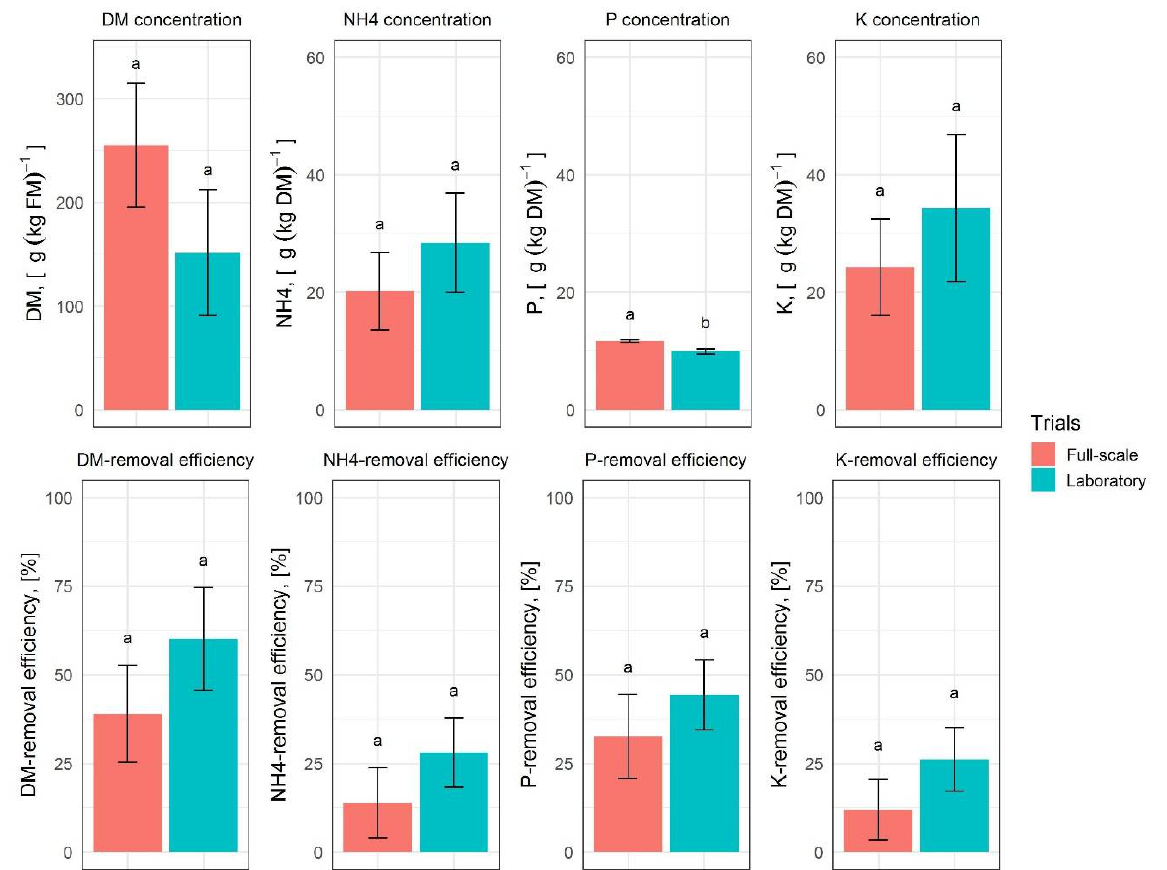
Figure 3. Results of the separation trials in the full-scale and laboratory systems. The upper diagrams show the concentration of nutrients in the full-scale and laboratory. The lower diagrams show the removal efficiency. Histograms are charted based on the mean values; error bars indicate the variability between the three replications. Lower case letters indicate significant differences according to the results of the Tukey test.